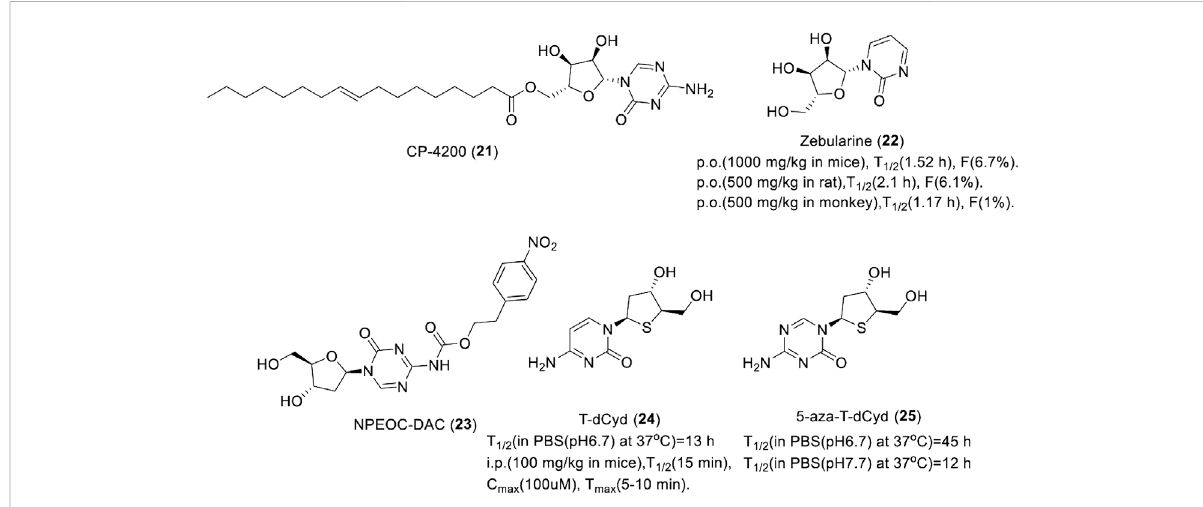
FIGURE 5 Chemical structure of nucleoside DNMTis in preclinical.